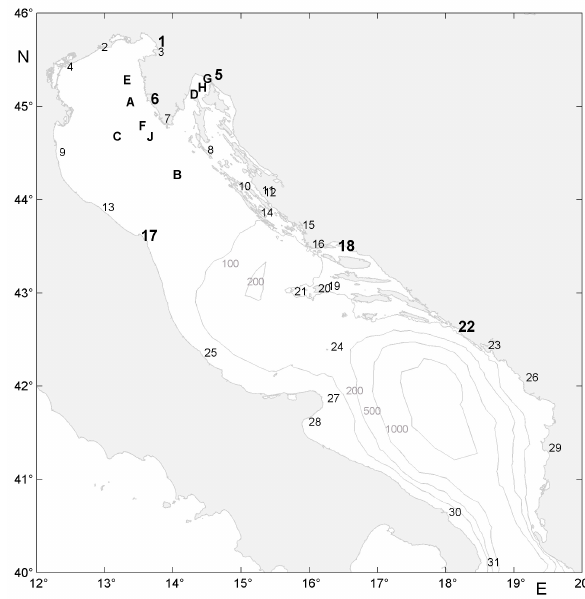
Fig. 1. Location map with bathymetry of the Adriatic Sea. Gauge stations based on literature values are represented with numbers, those with our analysis results as large bold numbers. Locations of Aanderaa RCM-4 current meter stations are marked with letters A–H and the ADCP station with the letter